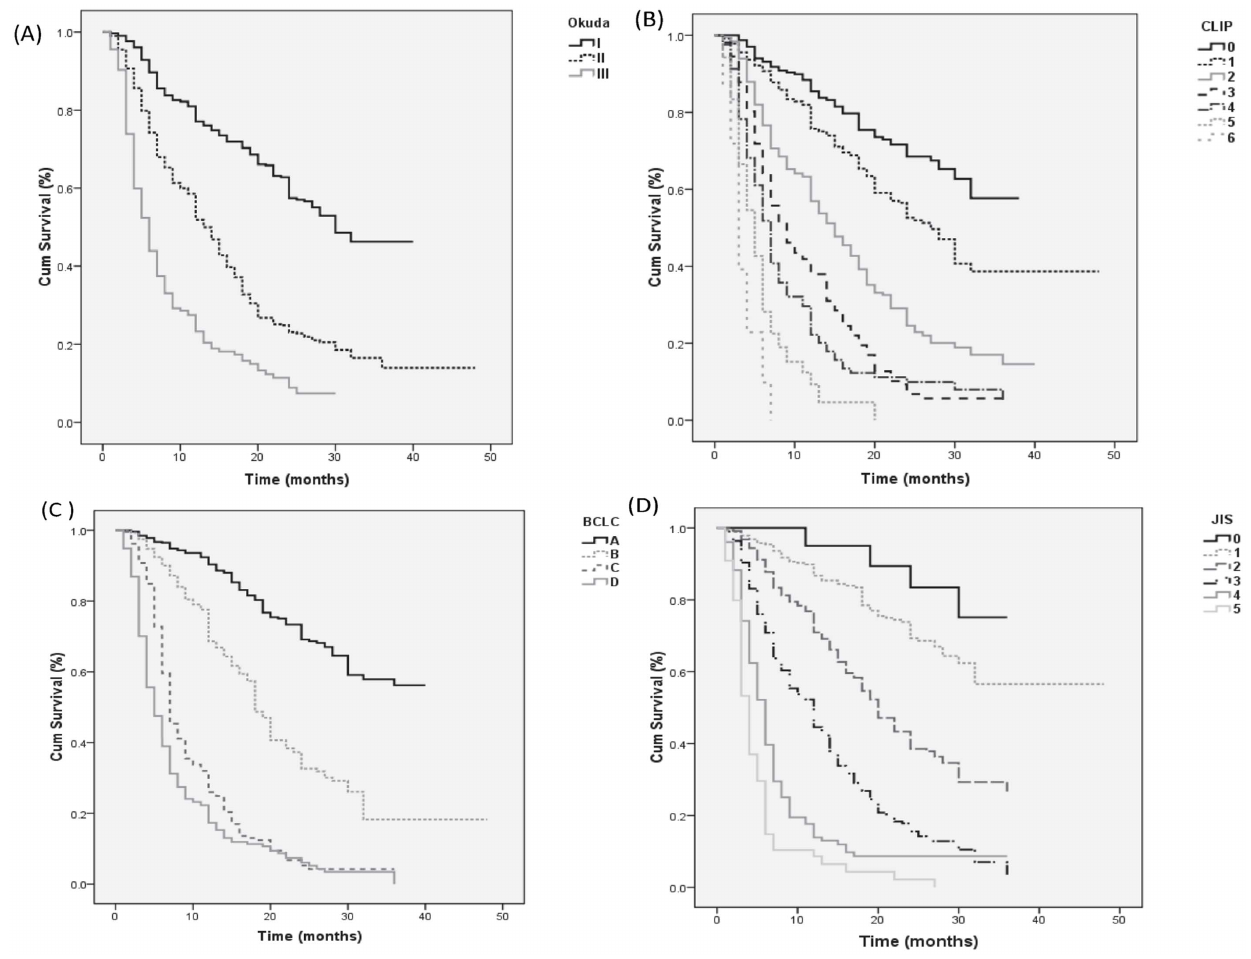
Figure 1. Survival curves for whole cohort. Kaplan-Meier survival curves for patients with hepatocellular carcinoma by staging system: (A) Okuda, (B) Barcelona Clinic Liver Cancer, (C) Cancer of the Liver Italian Program, (D) Japan Integrated Staging score.